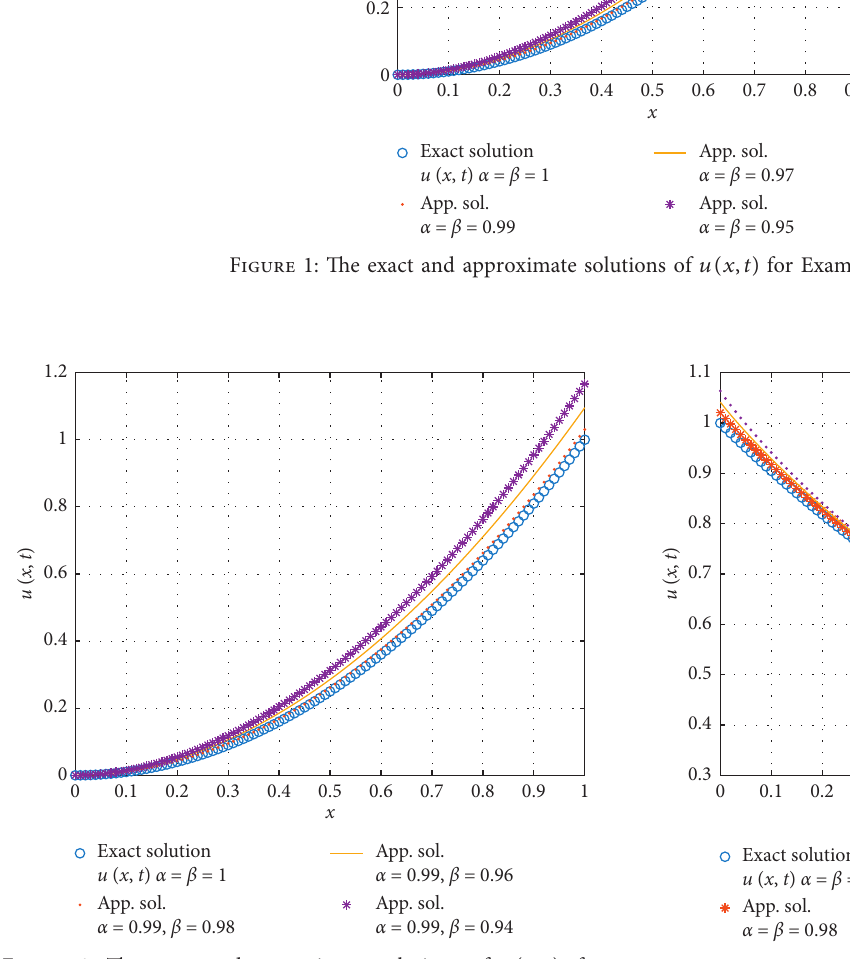
Figure 3: The exact and approximate solutions of u ( x,t ) for Example 4, when α � β